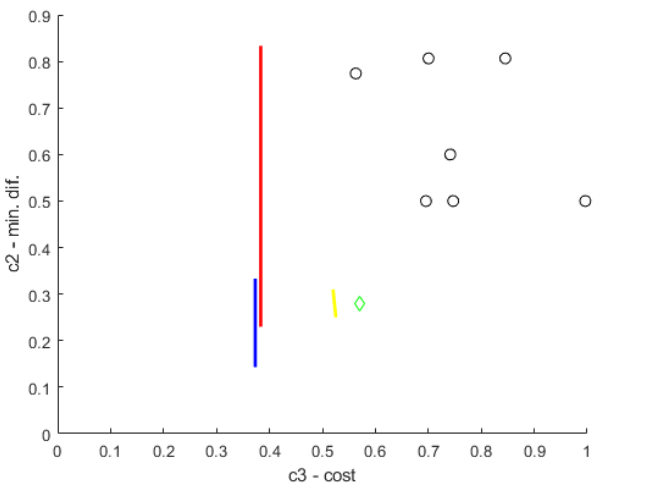
Figure 13. Comparison of crossover fraction.